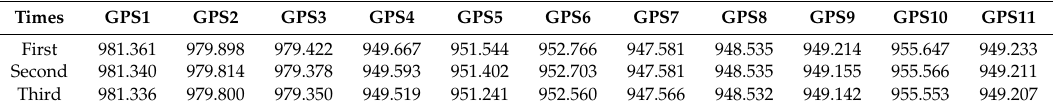
Table 2. The real-time kinematic (RTK) measurements of GPS stations, (unit: meter).